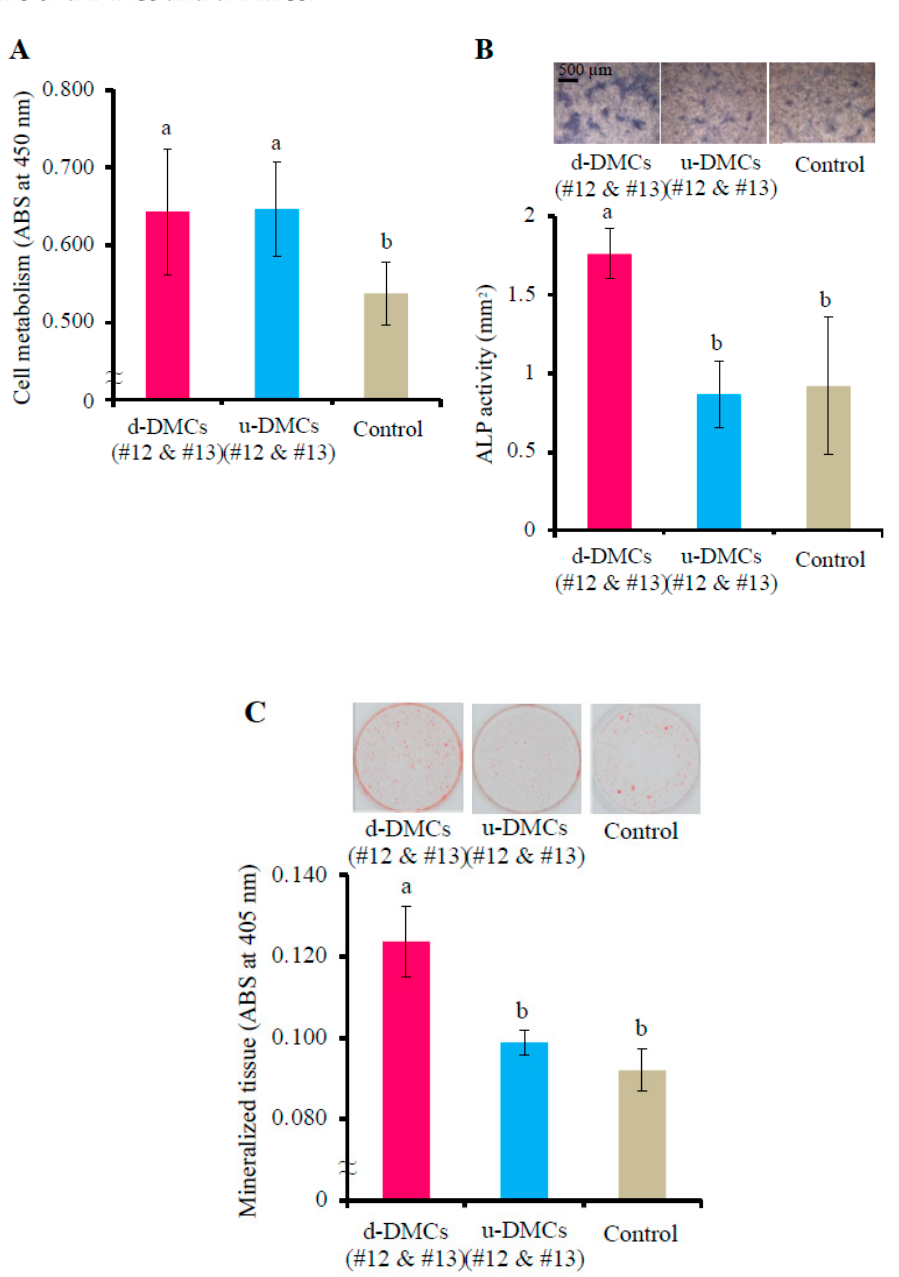
Figure 3. Effects of the fractions on RPPCs in vitro . Effects of fractions #12 and #13 from d-DMCs on pulp cell metabolism ( A ), alkaline phosphatase (ALP) activity ( B ), and mineralization ( C ) ( n = 6 per group). Data are representative of five independent experiments. Quantitative data are the means ± s.e.m. Groups with similar lowercase letters (i.e., a and b) are not significantly different ( p > 0.05).